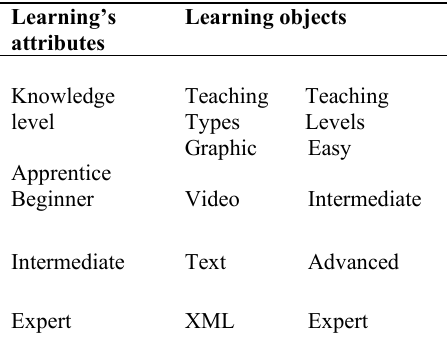
Table 1. Learning Attributes and Learning